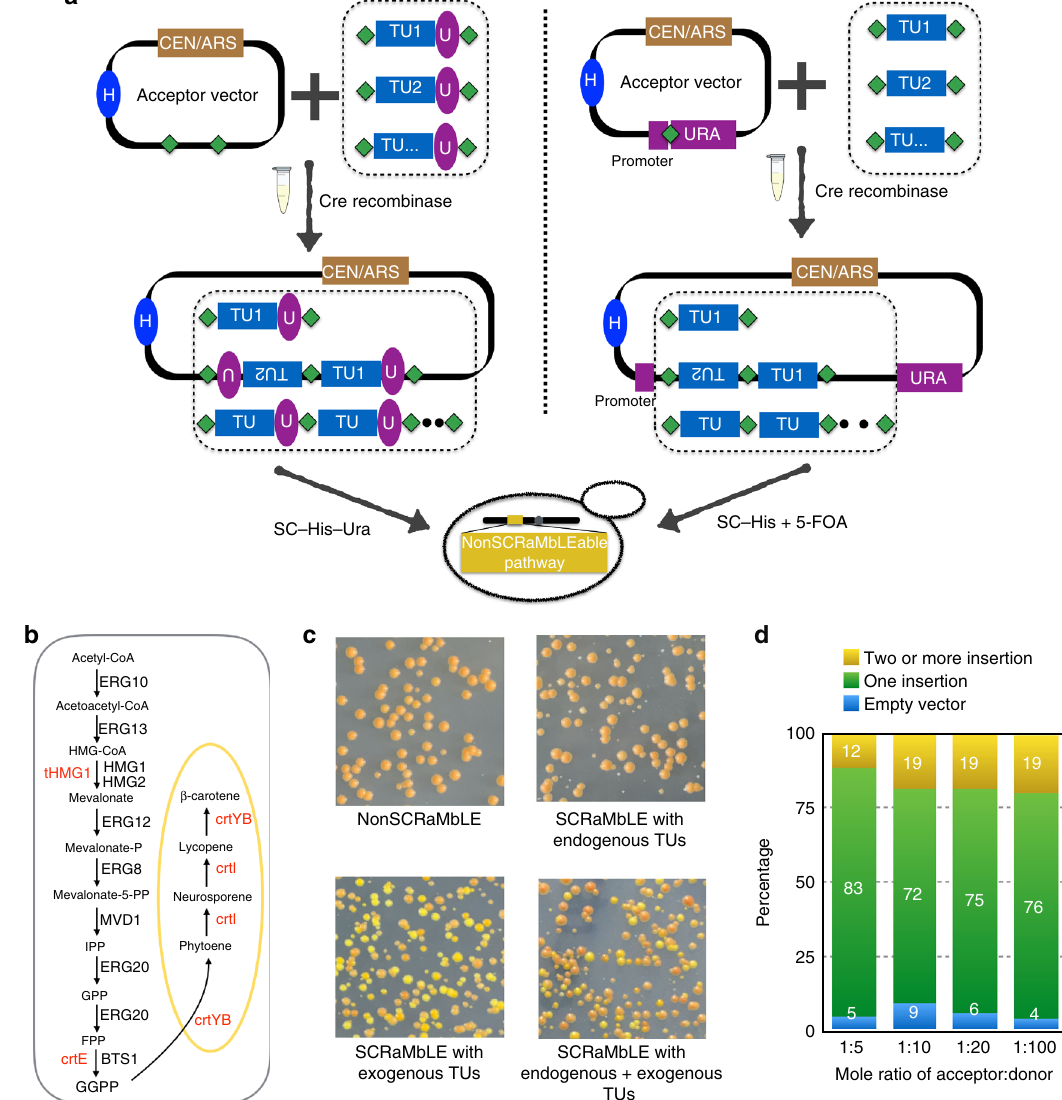
Fig. 3 Bottom-up in vitro SCRaMbLE. a Schematic of two independent bottom-up in vitro SCRaMbLE strategies. Left panel — donor fragments each carry a TU and a URA3 gene. The acceptor vector encodes two loxPsym sites (green diamond). Right panel — a loxPsym site is inserted in frame with the URA3 coding sequence (Supplementary Fig. 10). Donor fragments are fl anked by loxPsym sites. In both cases, the acceptor vector and the pool of donor TUs constructs are mixed with Cre recombinase in vitro. The donor TUs will be randomly inserted into loxPsym sites of the acceptor vector. Note that in bottom-up SCRaMbLE the core β -carotene pathway itself is not in a SCRaMbLE format (i.e., unlike “ top down ” , there are no lox sites fl anking core pathway genes). (yellow box “ NonSCRaMbLEable pathway ” integrated into genome). Transcription unit (TU), HIS3 auxotroph marker (H), URA3 auxotroph marker (U). b Overview of the carotenoid biosynthetic pathway in S. cerevisiae . Genes shown in black are endogenous to S. cerevisiae . Genes shown in red are non- native, and derive from X. dendrorhous ( crtE , crtYB , crtI ), and one from S. cerevisiae (truncated 3-hydroxy-3-methylglutaryl-coenzyme A reductase